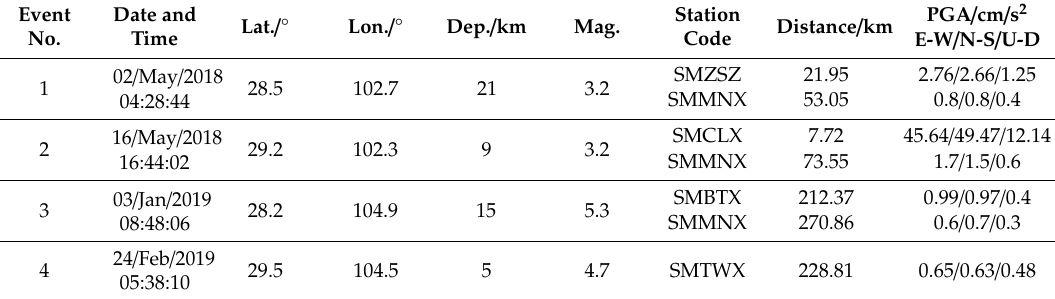
Table 5. Some minor or teleseismic events detected by the tested MNSMS